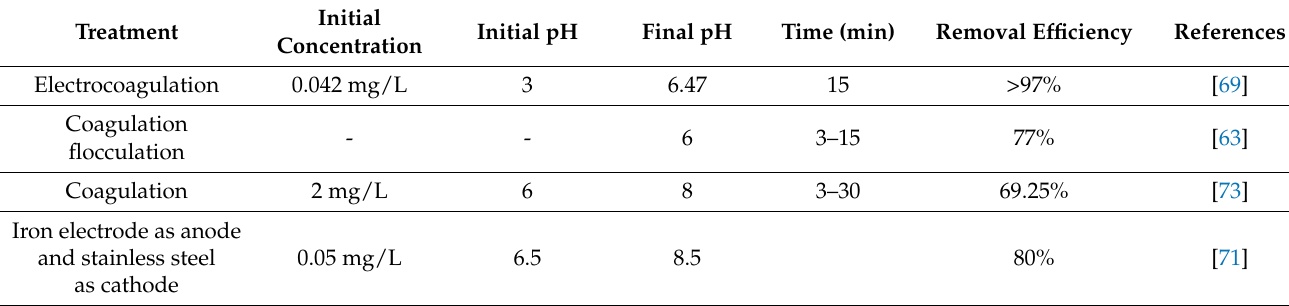
Table 3. The removal efficiency of coagulation–flocculation